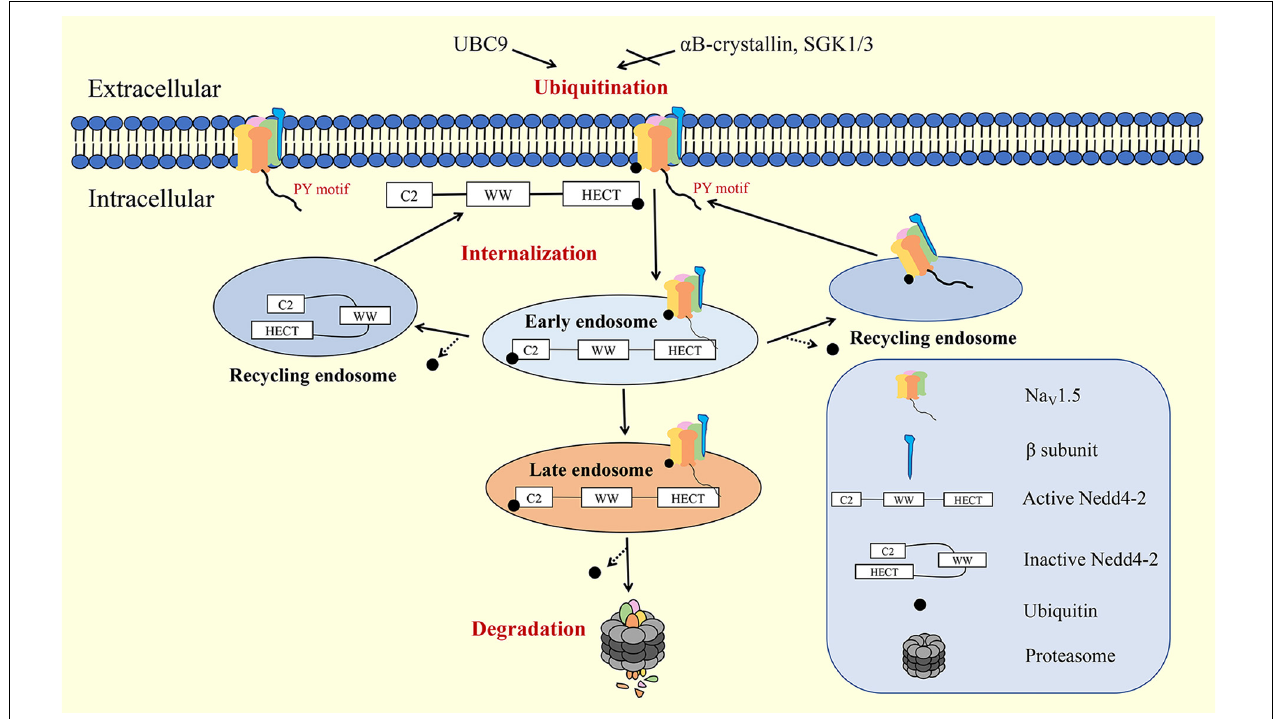
FIGURE 3 | Internalization and degradation of Na V 1.5 on the plasma membrane. Nedd4-2, neural precursor cell-expressed developmentally downregulated 4 type 2; SGK, serum- and glucocorticoid-inducible